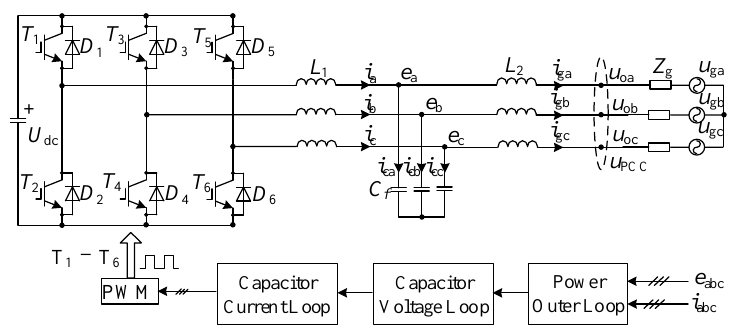
Figure 1. Overall diagram of a VSG grid-connected inverter system.